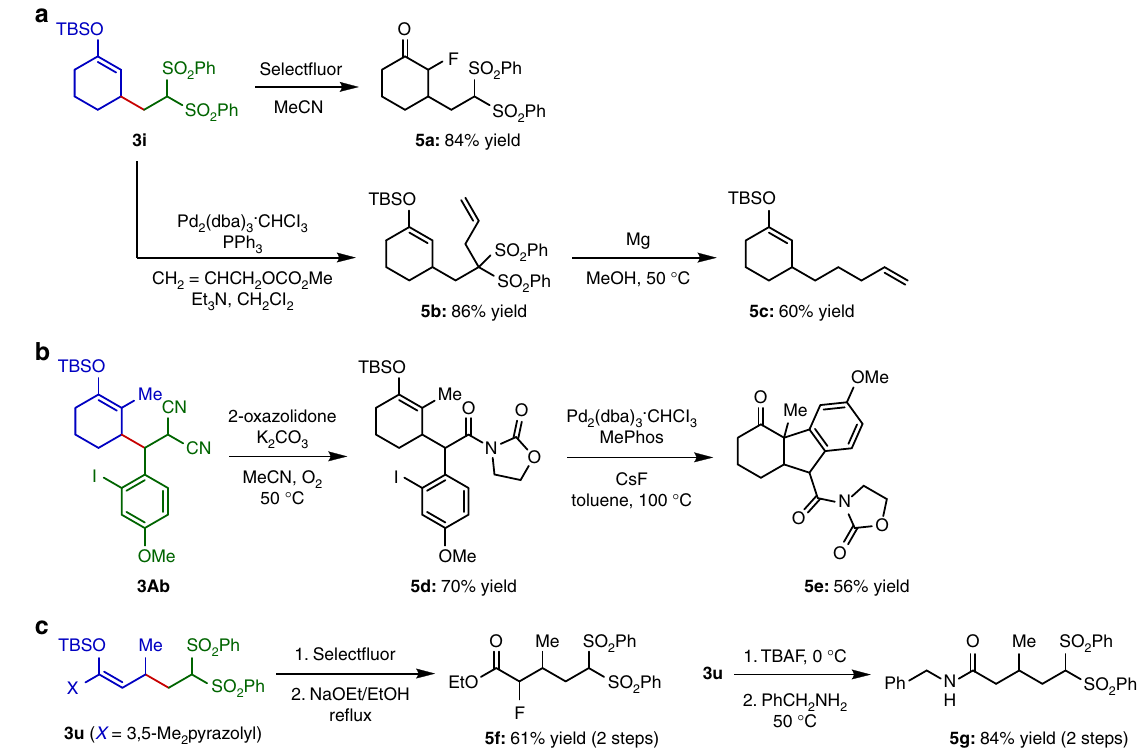
Fig. 4 Diverse transformations of alkylated products. a Derivatizations of alkylated enol silyl ether 3i . b Synthesis of complex fused tricyclic ketone 5e from alkylated enol silyl ether 3Ab . c Derivatizations of alkylated ketene silyl hemiaminal